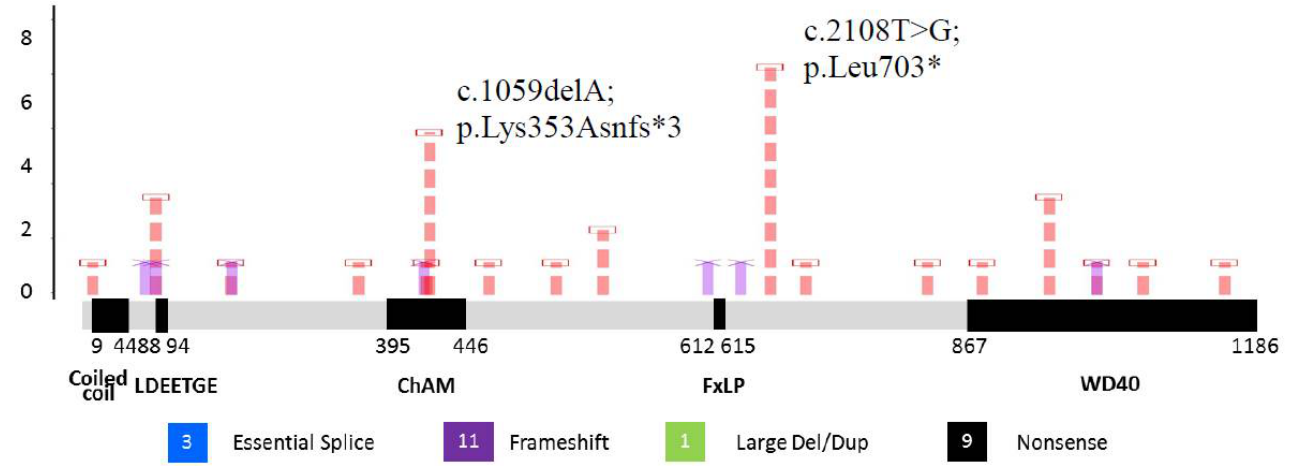
Figure 2. Mutations found in PALB2 . ChAM: chromatin association motif; LDEETGE: extended EDGE motif; novel mutation; recurrent mutation. Table 4. Germline heterozygous variants identified in PALB2 .